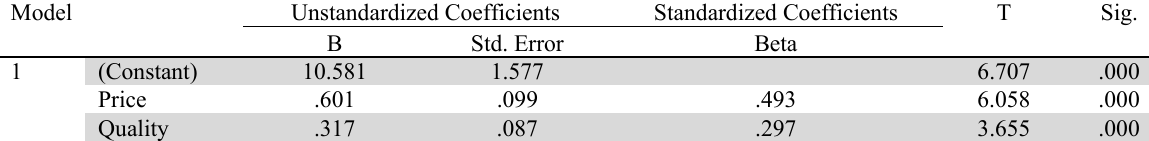
Model 3 Multiple Linear Regression Test Results (Coefficients a )